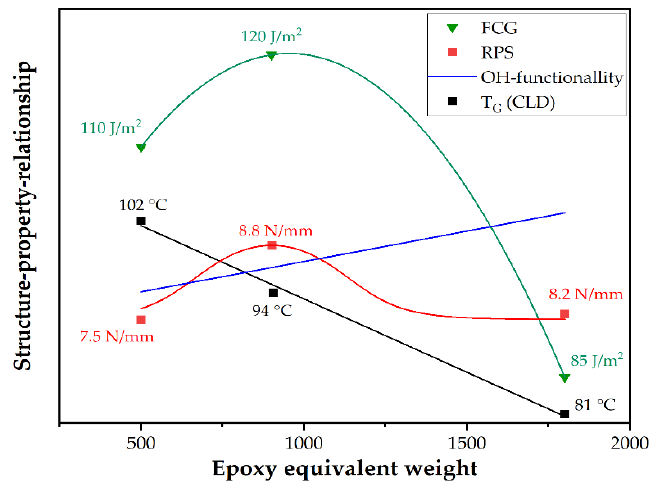
Figure 10. Schematic relationship of OH functionality, crosslinking density (CLD), roll peel strength (RPS) and fatigue crack growth kinetics (FCG) at ambient temperature and the epoxy equivalent weight (EEW) of the adhesive in electrical steel laminates.